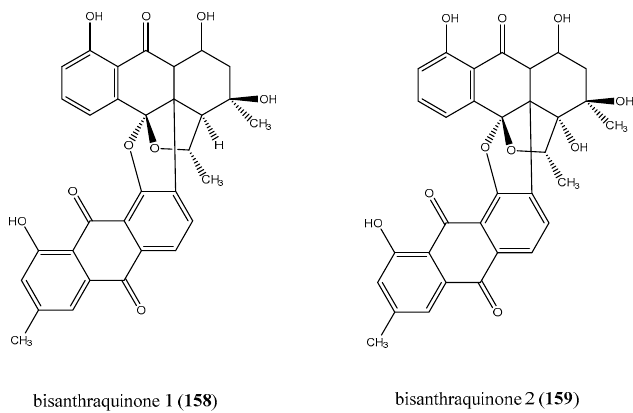
Figure 16. Structures of the cyanobacteria-derived bisanthraquinones 1 and 2 ( 158 and 159 ).